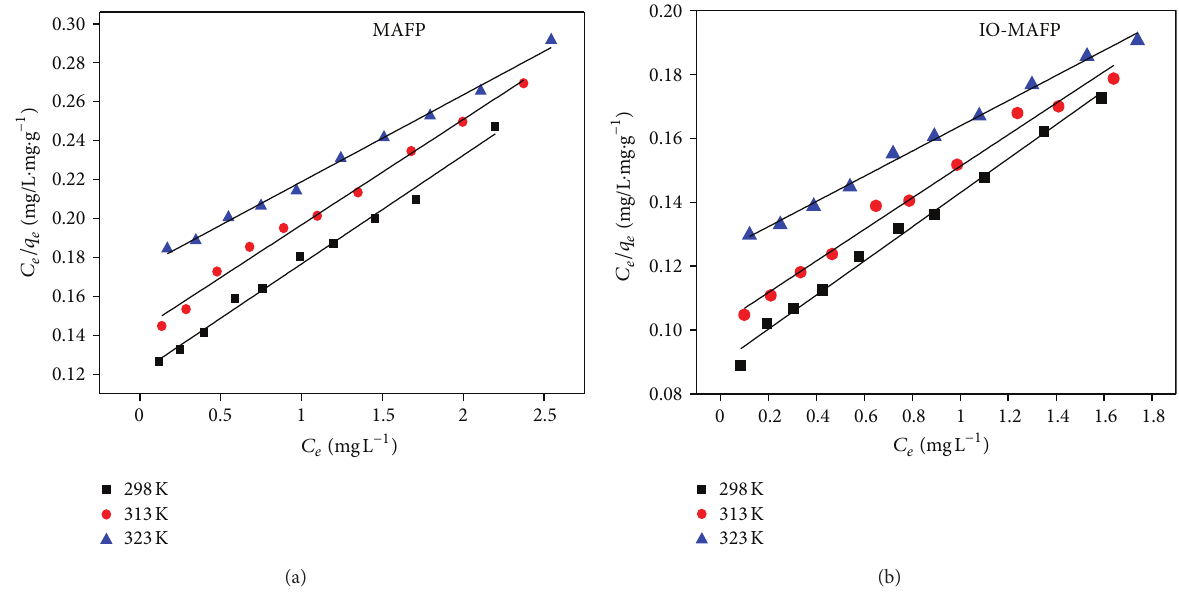
Figure 11: Langmuir isotherms of Co(II) sorption onto MAFP and IO-MAFP biomasses. Table 3: Isotherm parameters of Co(II) with MAFP alone and IO-MAFP